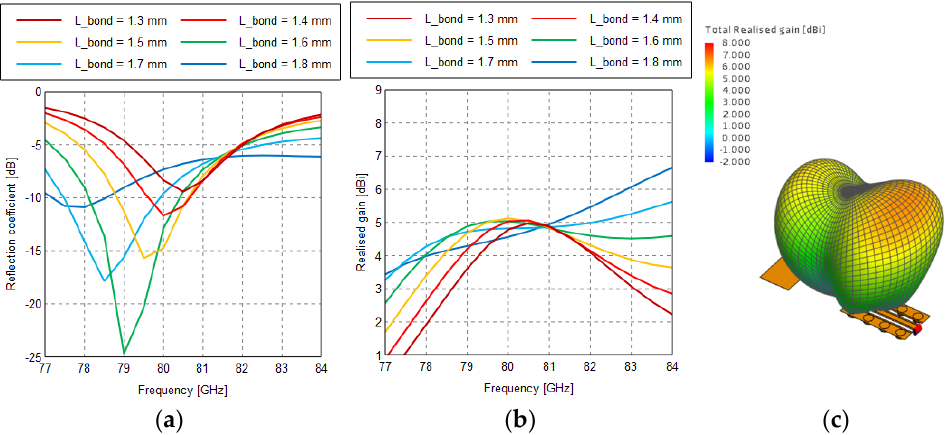
Figure 3. Simulations of the experimental design having different wire bond lengths around half- wavelength: ( a ) reflection coefficient; ( b ) realized gain (reflection loss included), broadside direction; ( c ) radiation pattern at 80 GHz for the bond length of 1.6